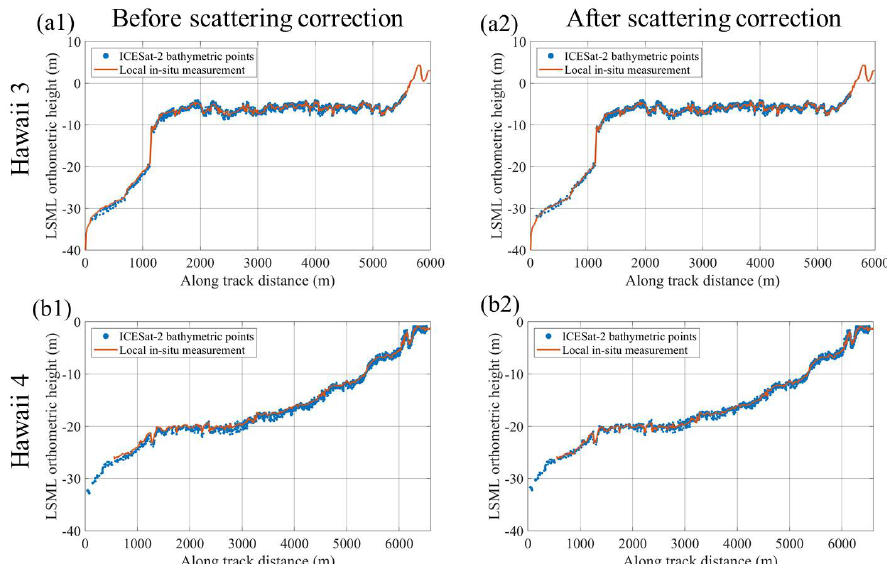
Figure 9. Comparisons between ICESat-2 along-track bathymetric points and truth profiles (calculated from local in situ measurements) at Hawaii. Two left subfigures ( a1 , b1 ) correspond to ICESat-2 points without water forward-scattering corrections, whereas ( a2 , b2 ) correspond to those with scattering corrections. It should be noted that all height values are in LMSL orthometric heights.